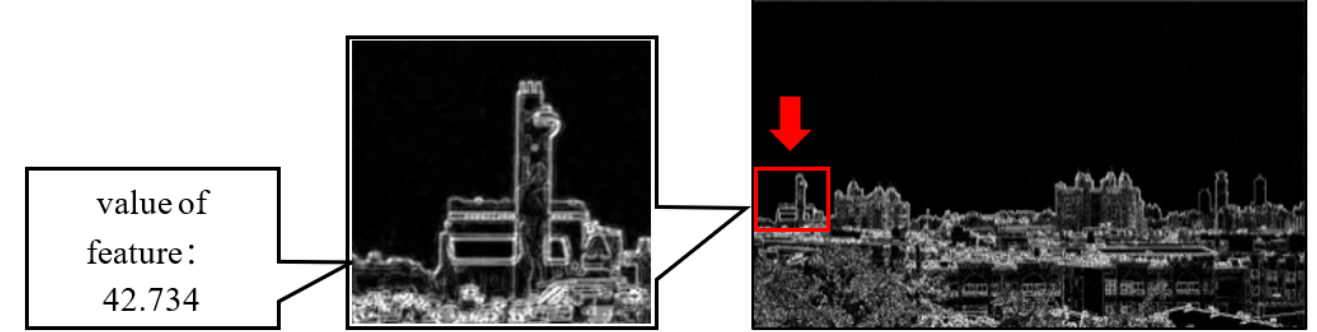
Figure 7. The method for calculating the feature value in the RoI.